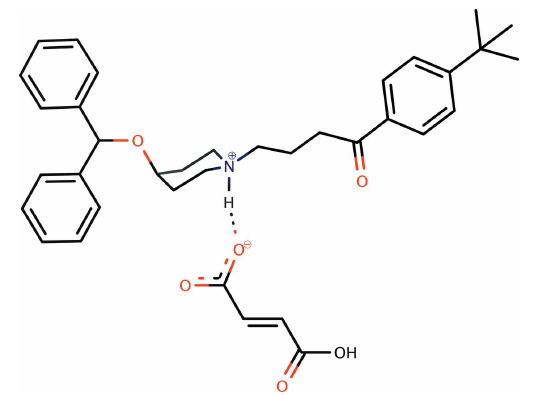
Table 1 Hydrogen-bond geometry (A˚ , (cid:4) ).